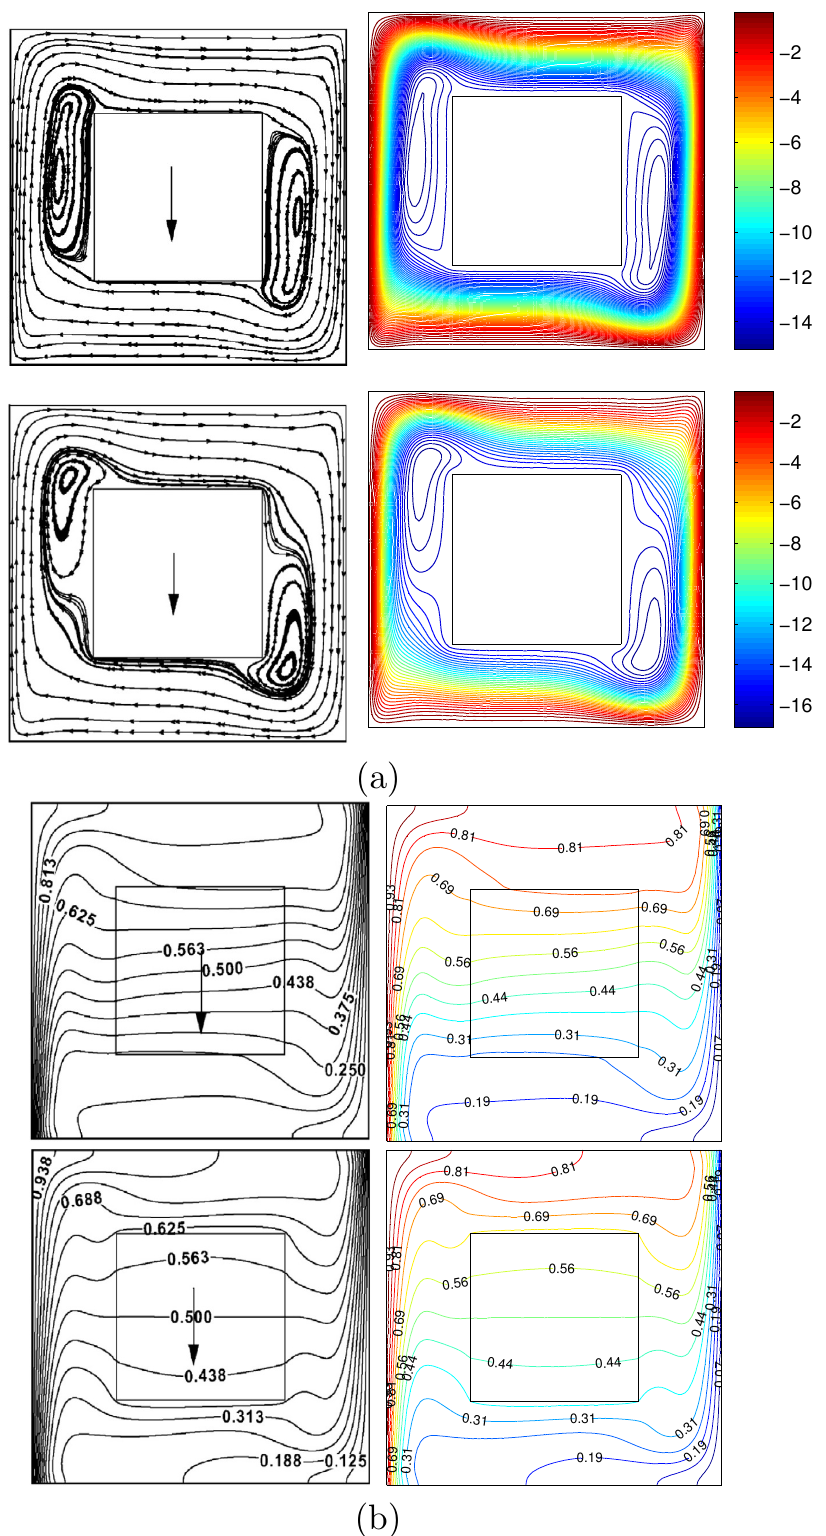
Figure 2. Streamlines ( a ), Das and Reddy [35] ( left ), present study ( right ); isotherms ( b ), Das and Reddy [35] ( left ), present study ( right ) for K r = 0.2 ( top ) and K r = 5 ( bottom ) at Ra = 10 6 , φ = 0 and D =